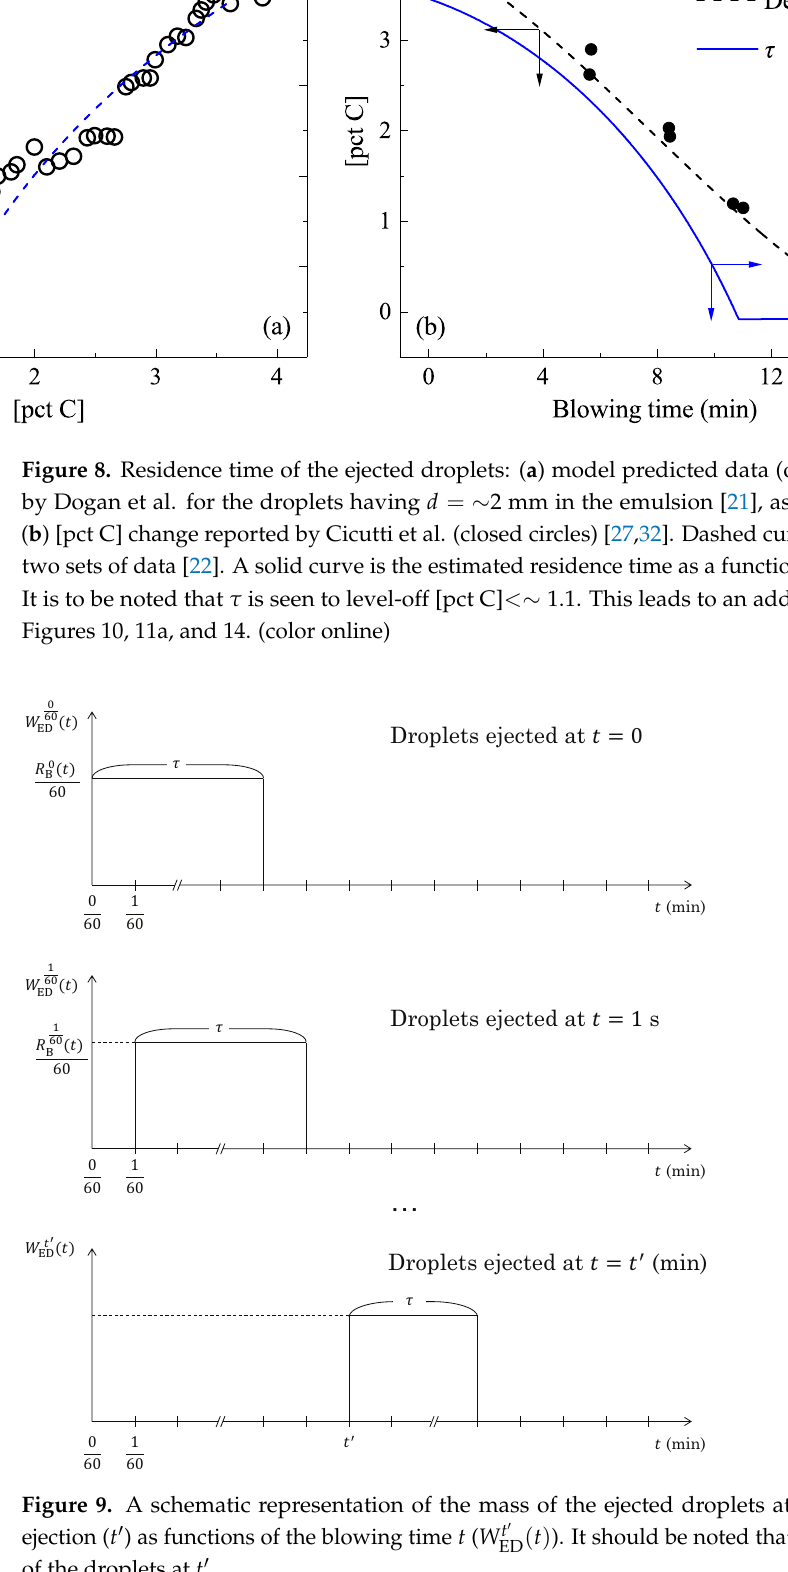
( t ) ). It should be noted that τ depends on [pct C] ED